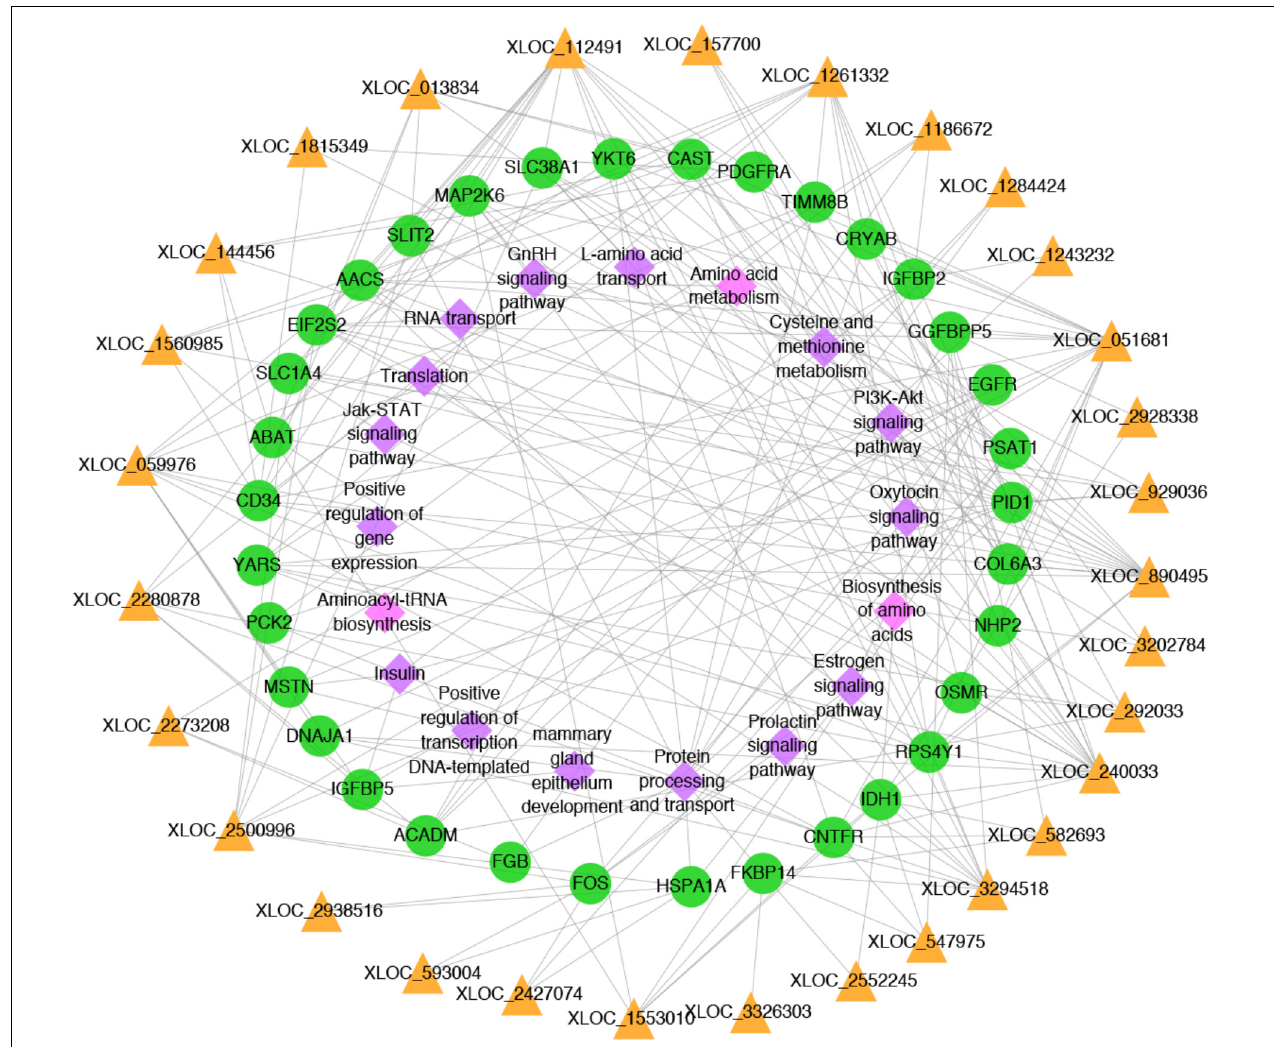
FIGURE 6 | Network plot of candidate lncRNAs, mRNAs and pathways. The yellow triangles, green circles and pink diamonds represent lncRNAs, mRNAs and pathways,